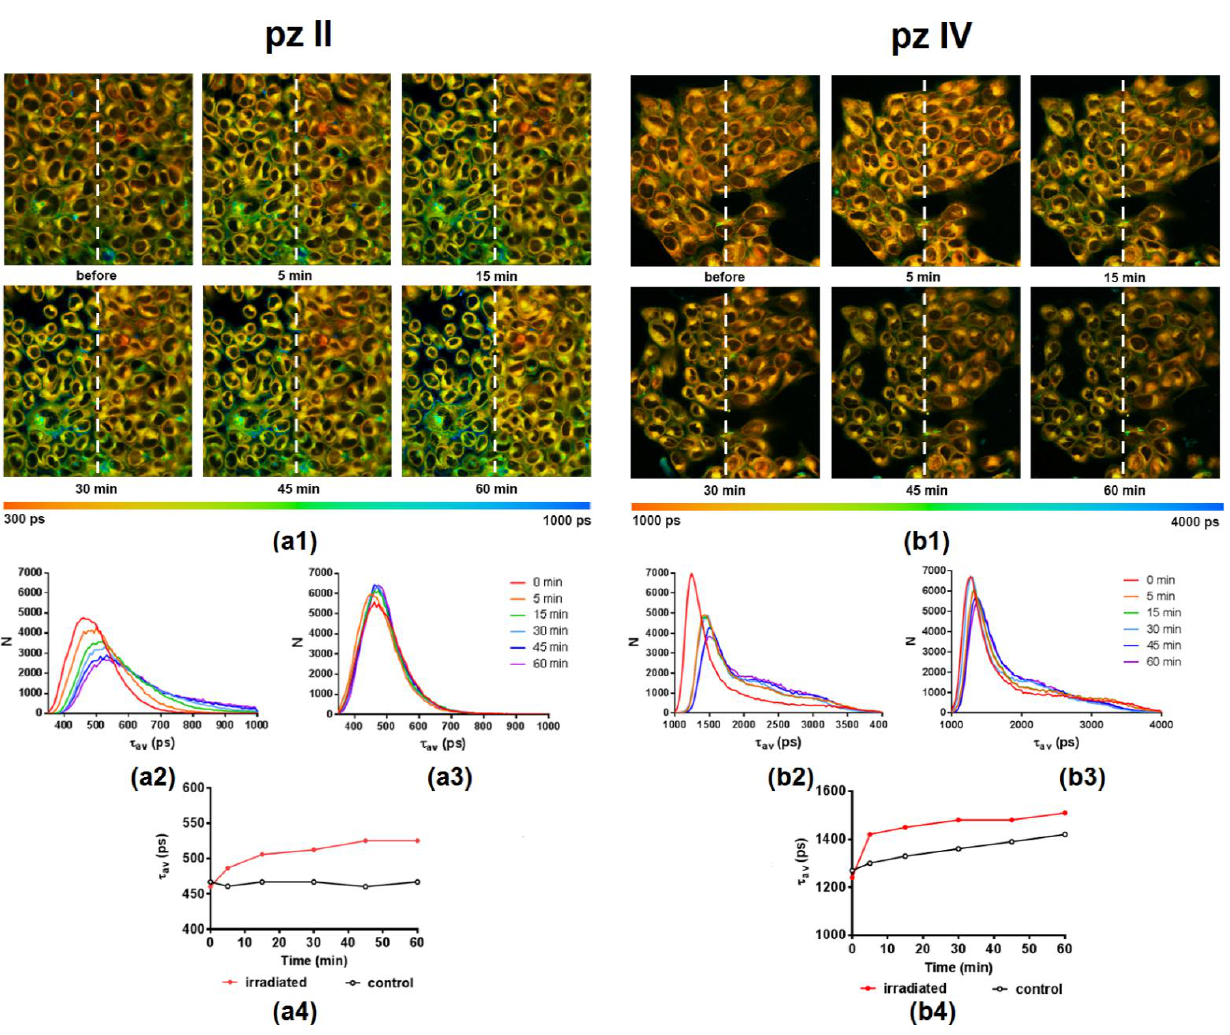
Figure 10. Representative FLIM images illustrating pz II’s ( a1 ) and pz IV’s ( b1 ) fluorescence lifetime ( τ av ) distribution in human epidermoid carcinoma A431 cells before and at different time points after PDT treatment. Photodynamic exposure (594 nm, 20 J/cm 2 ) was performed in the left half of the field of view; irradiated and control areas are divided by a white dotted line. λ ex , 800 nm, λ em , 652–740 nm. The color scale range is between 300 and 1000 ps for pz II and 1000 and 4000 ps for pz IV . Image size, 212 × 212 µ m. The distribution histograms of a fluorescence lifetime ( τ av ) in irradiated and control regions for pz II ( a2 , a3 ) and pz IV ( b2 , b3 ) and the plot of τ av vs. time after irradiation ( a4 , b4 ) are shown.